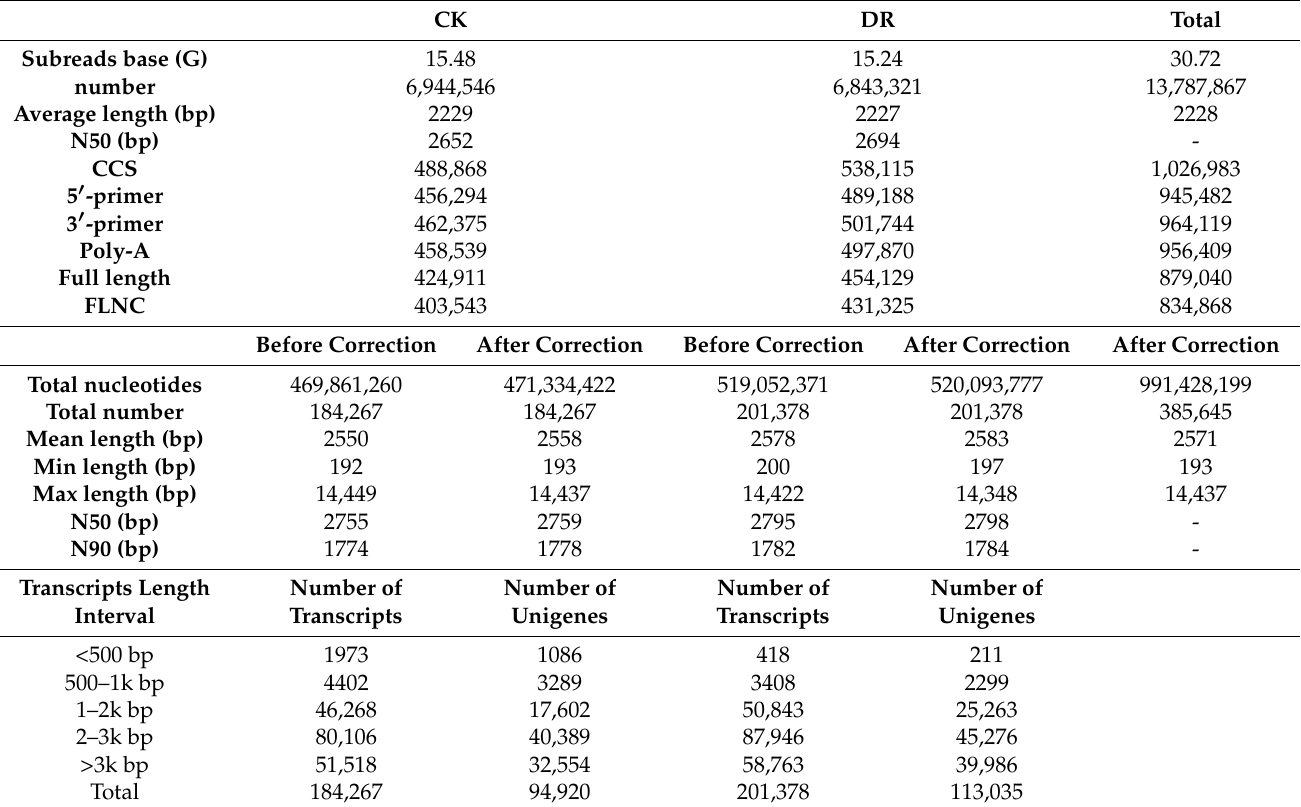
Table 1. Summary of Lolium multiflorum single-molecule real-time sequencing